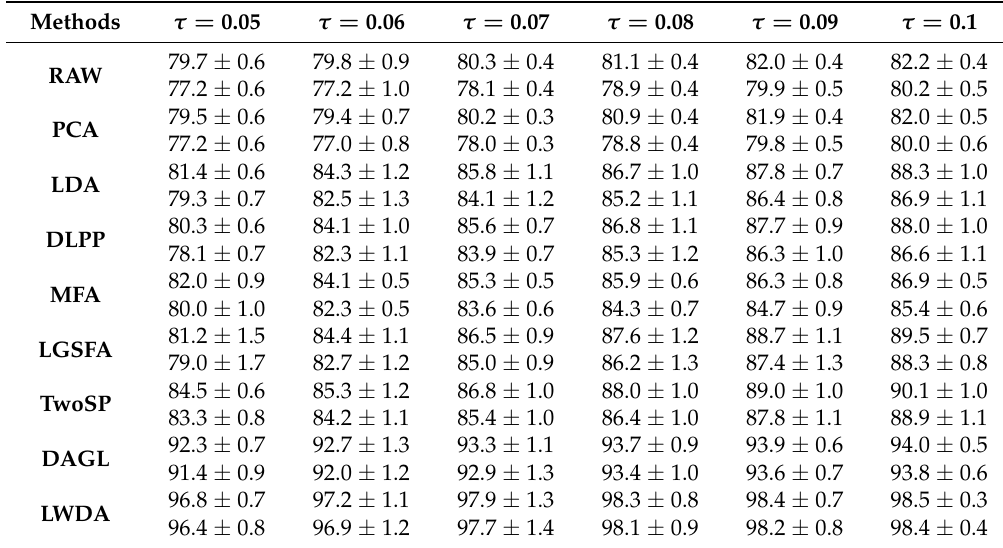
Table 7. Classification results (%) with different values of τ on the KSC dataset with NN classifier. Each method has two rows, where the first row is the OA ± STD and the second row is the KC ± STD. Methods τ = 0.05 τ =